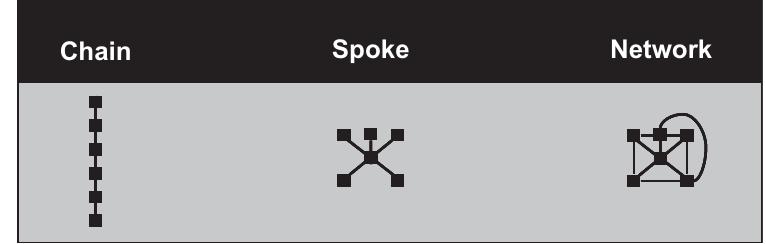
Figure 1. Concept maps comprise three basic structures (after Kinchin, Hay, and Adams